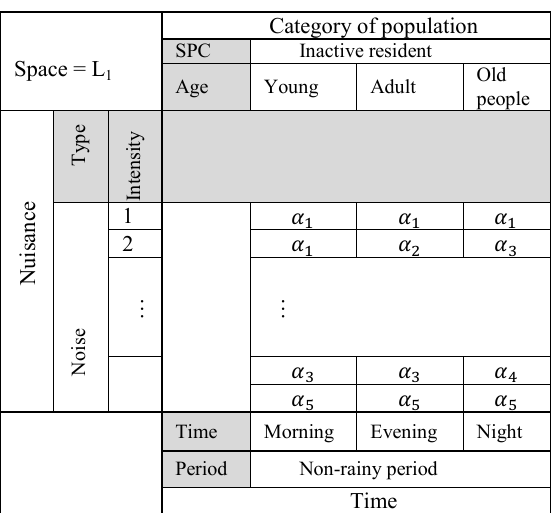
Table 2. Application: example of annoyance evaluation